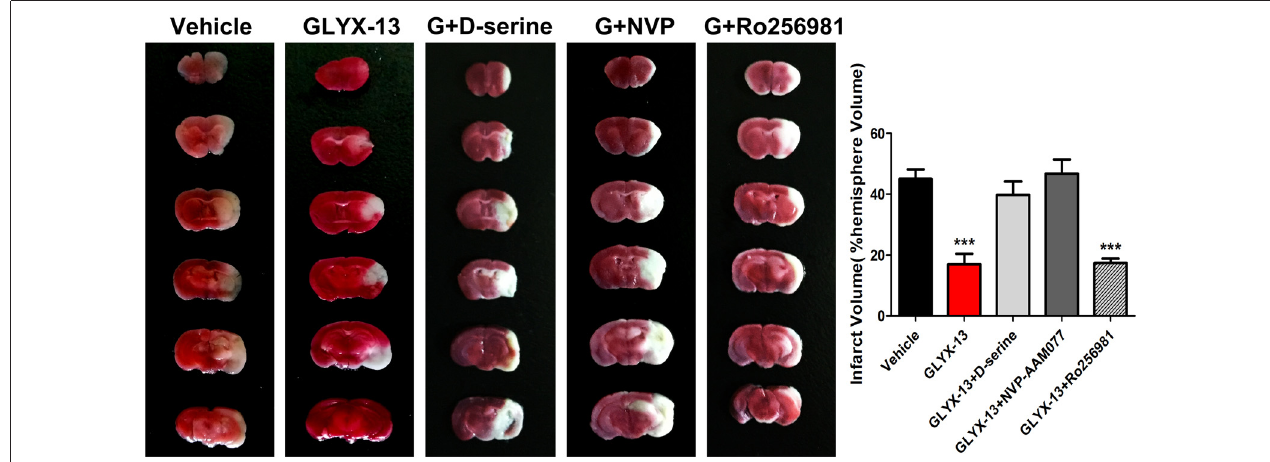
FIGURE 12 | GLYX-13 reduced cerebral infarct volume through enhancing NR2A-containing components and decreasing NR2B-containing components in vivo MCAO ischemia model. Representative brain sections were stained with TTC under various treatments. Unstained area is infarct. GLYX-13 treatment along with selective NR2B antagonist (Ro256981 5 mg/kg) 2 h after 1 h MCAO challenge failed to display any additional neuroprotective effects; by contrast GLYX-13 treatment along with selective NR2A antagonist (NVP-AAM077 2.4 mg/kg) reversed the amelioration of infarct volume produced by GLYX-13 ( n = 6, ∗∗∗ p < 0.001, compared with